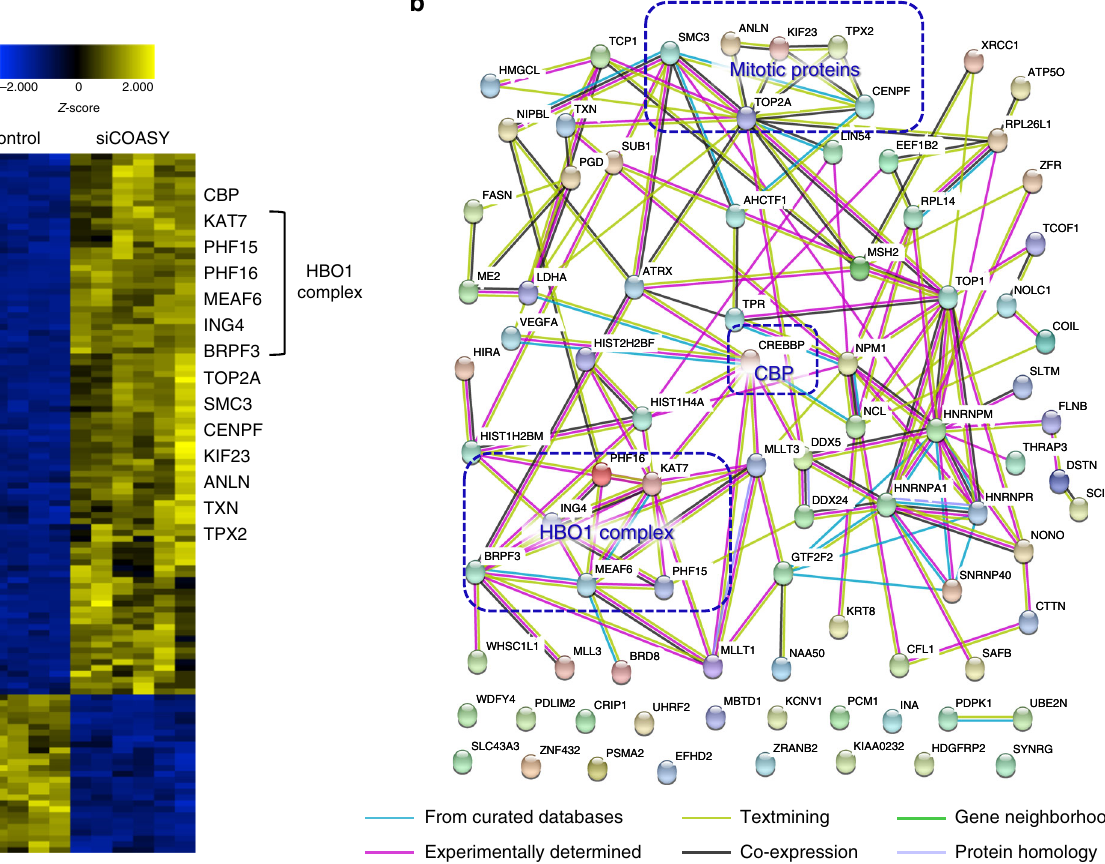
Fig. 2 COASY knockdown leads to hyper-acetylation of a protein network. a Heatmap and hierarchical clustering of a subset of selected peptides whose levels have been signi fi cantly altered in A549 cells by COASY knockdown ( n = 119); p < 0.001 (two-tailed Student ’ s t -test). b Functional protein association network of hyperacetylated proteins under COASY knockdown generated using STRING database